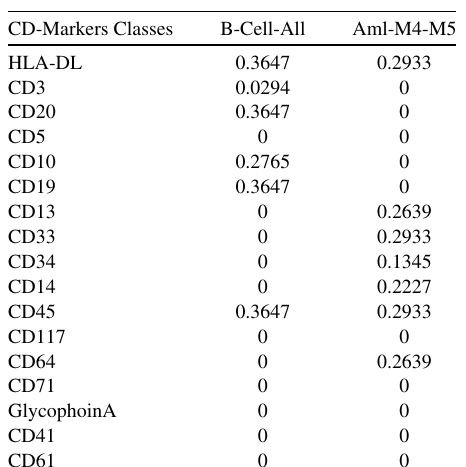
Shapley value assigns different values (weights) to each marker of B Cell All and Aml M4 M5 CD-Markers Classes